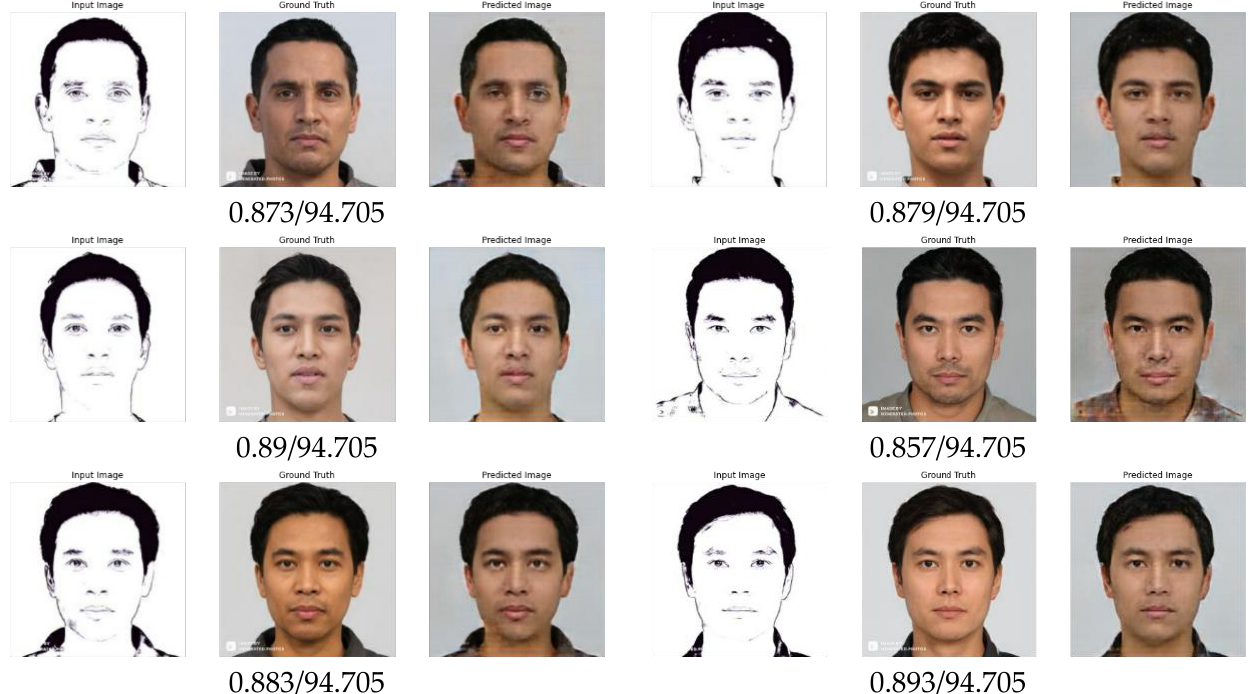
Figure 4. Result of cGAN-TV on validation dataset (ground truth images by generated photos [17]) with the best scenario. The values below the predicted images represent SSIM/FID from the cGAN-TV results. Table 4. Result of cGAN-TV on validation and testing data.